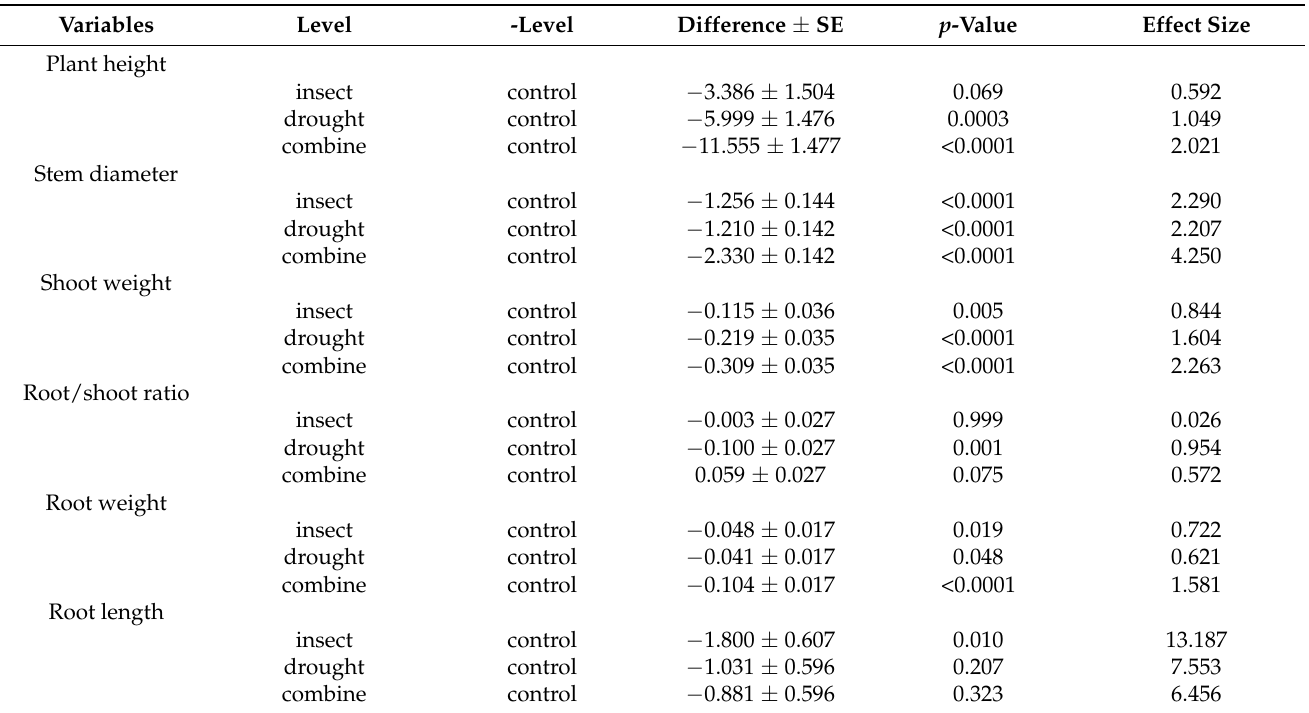
Table 1. Dunnett statistics within Analysis of covariance (ANCOVA) for the independent variables (plant height, stem diameter, shoot weight, root-to-shoot ratio, root weight, and root